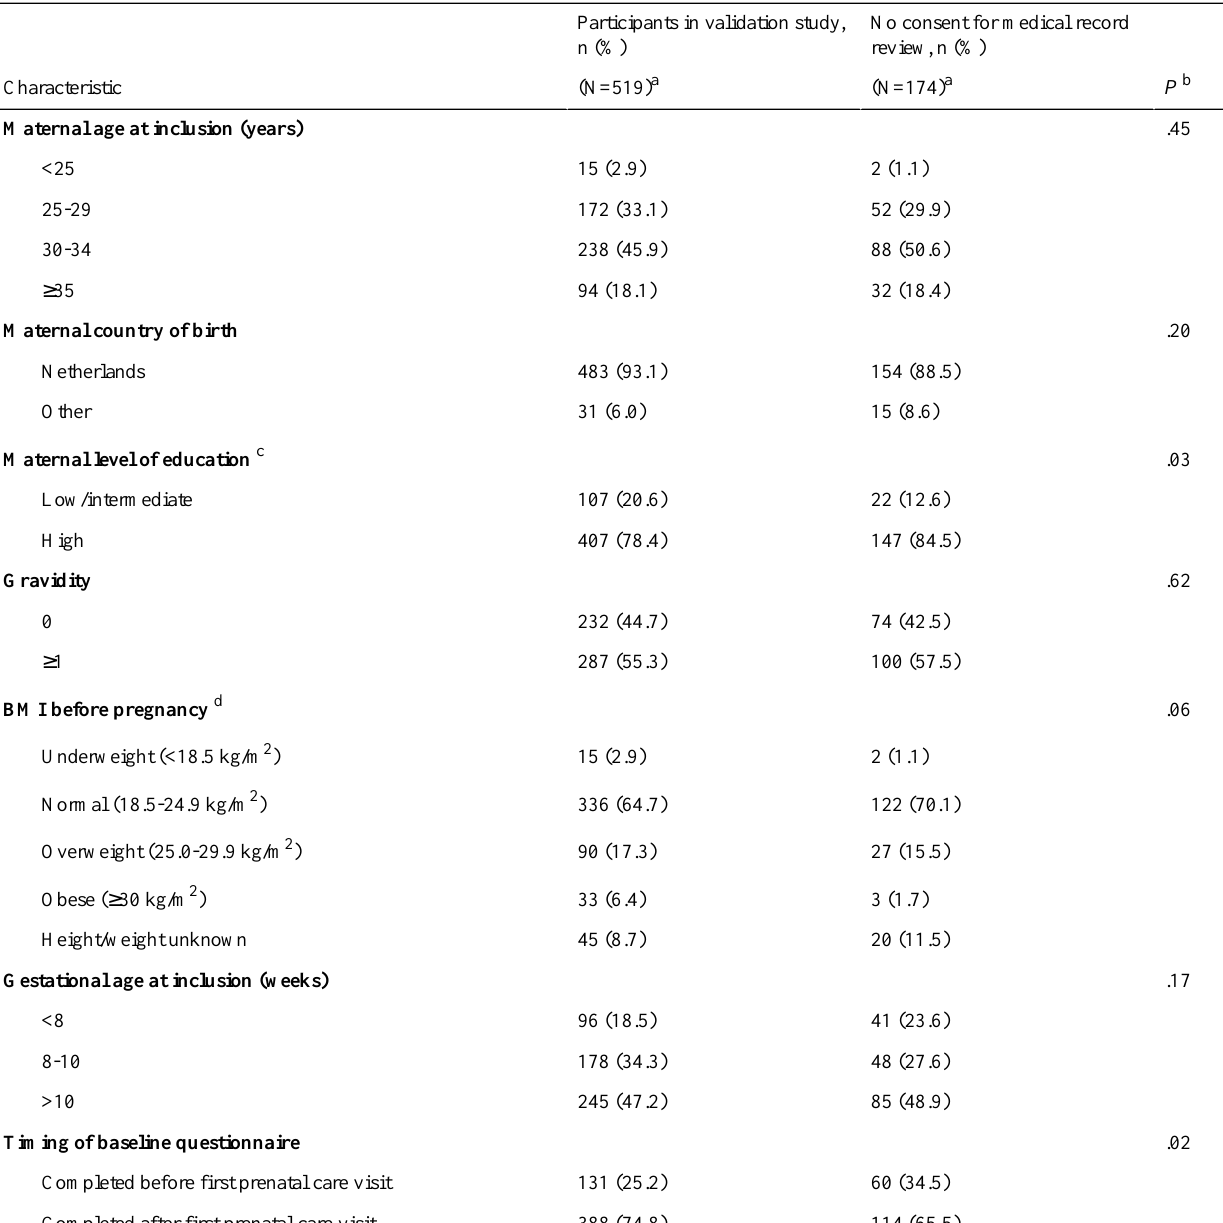
Table 1. Characteristics of PRIDE Study participants included in this validation study and participants who did not give consent for review of medical